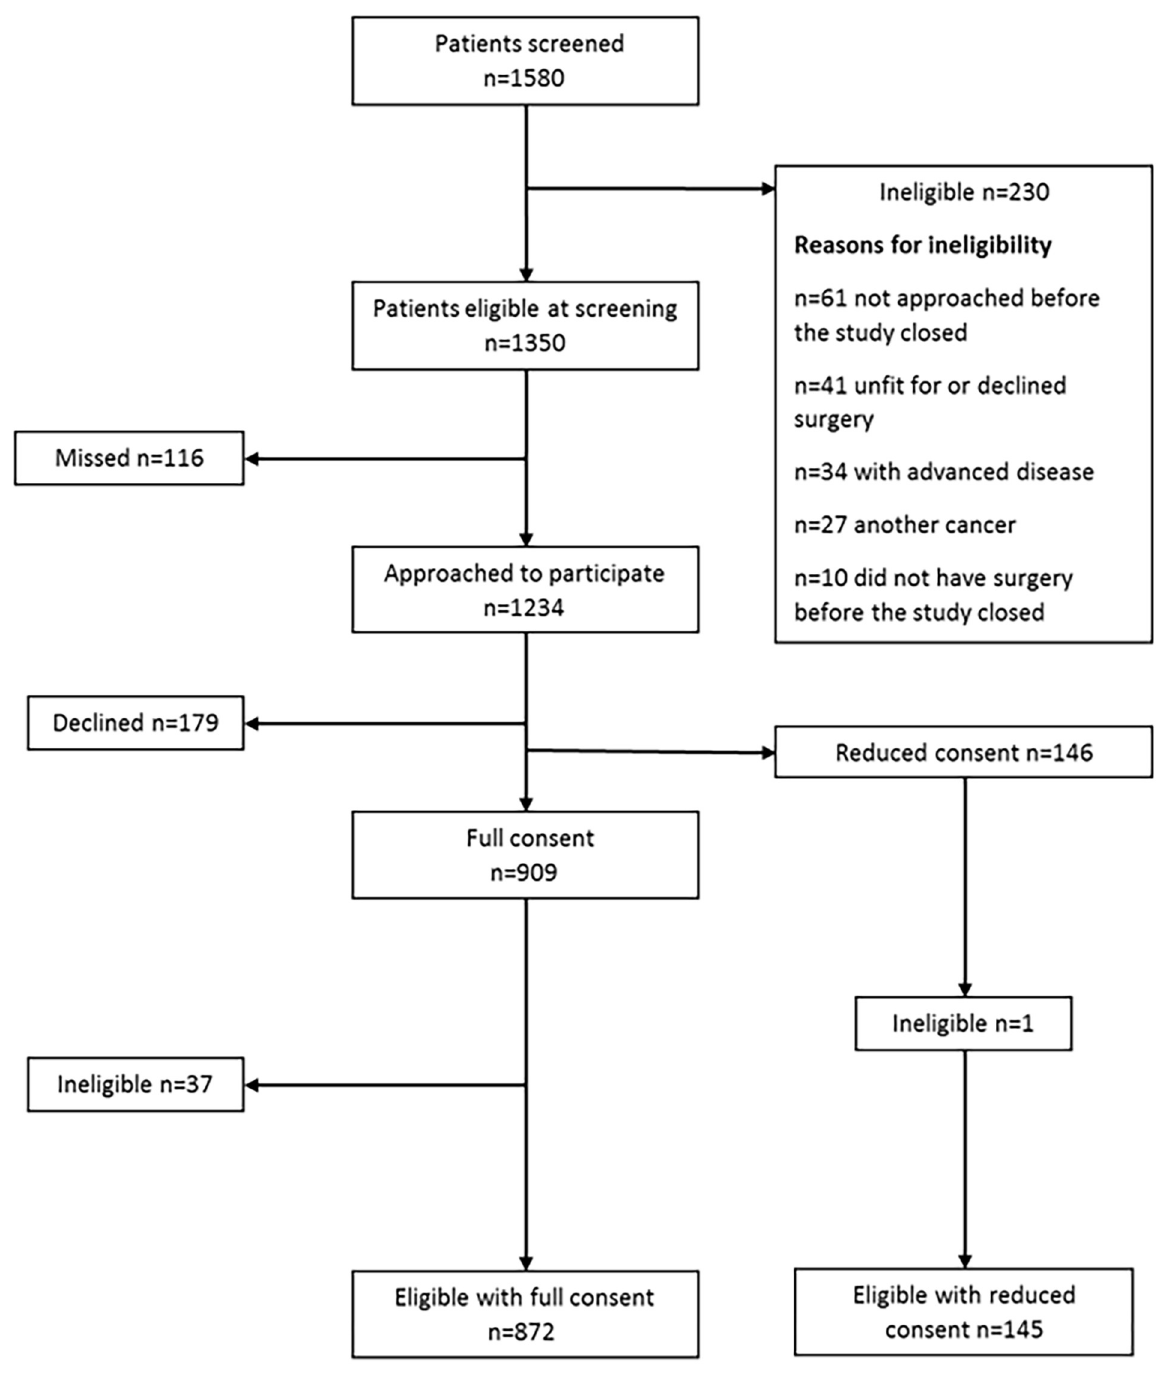
Fig 2. Flowchart showing screening of patients, eligibility and numbers